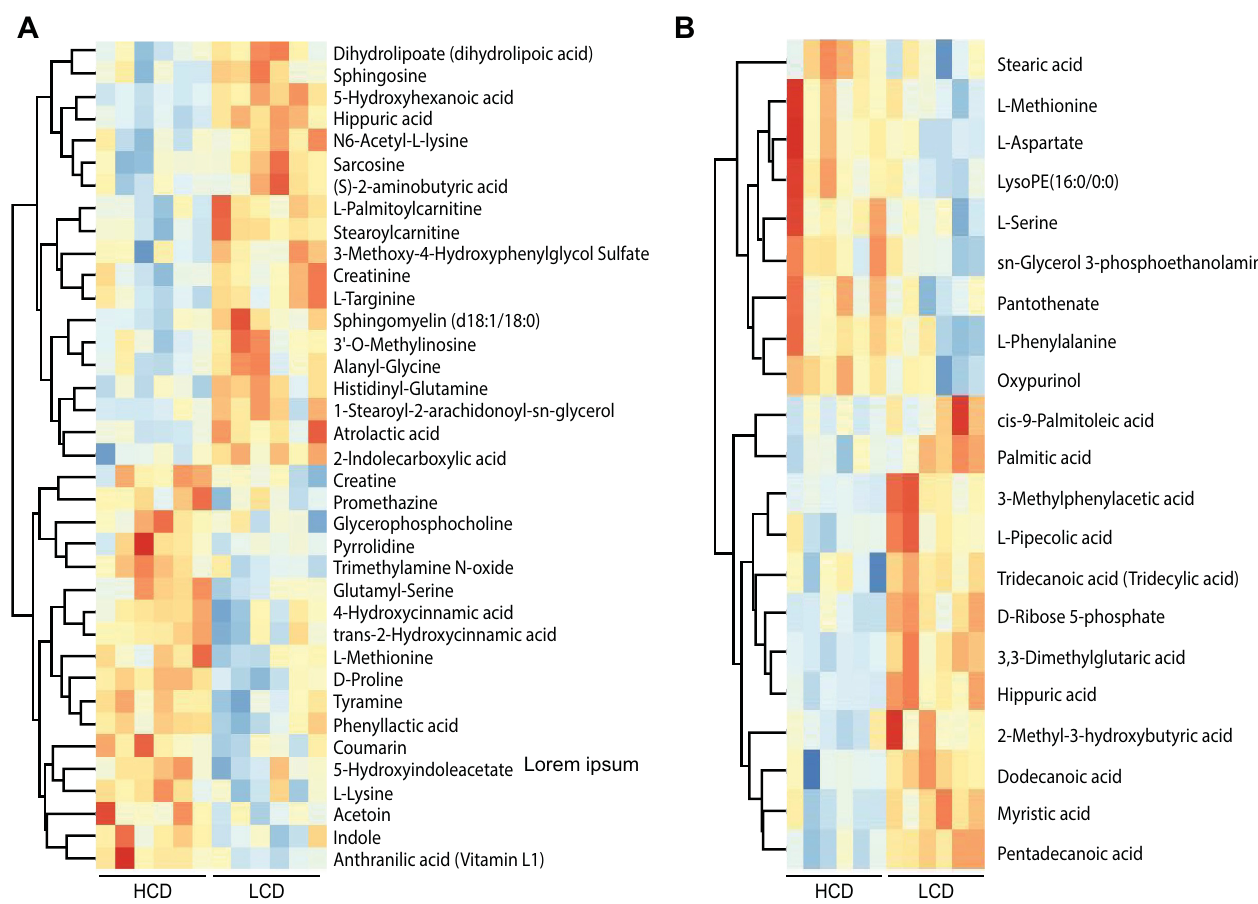
Fig 4. Heatmap of hierarchical clustering analysis of the differential plasma metabolites in beef cattle fed the high-corn diet (HCD) and the low-corn diet (LCD). A and B were derived from POS and NEG, respectively. Each column represents one beef steer, and each row represents one differential metabolite. The color of every cell represents the relative level of the differential metabolite, with red indicating high levels and blue low levels in plasma.